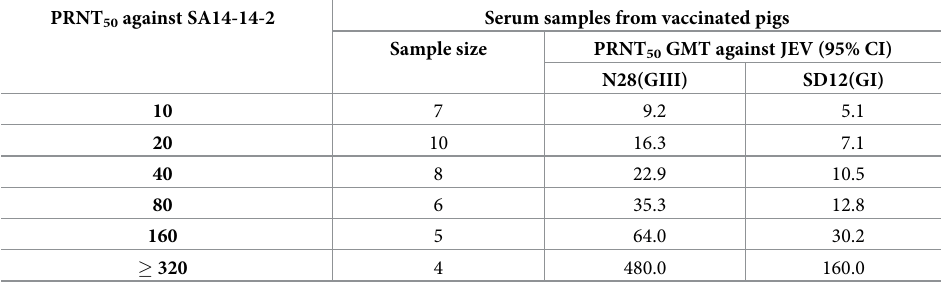
Table 2. Geometric mean titers (GMT) of PRNT50 titers specific to N28(GIII) and SD12(GI) strains in vaccinated